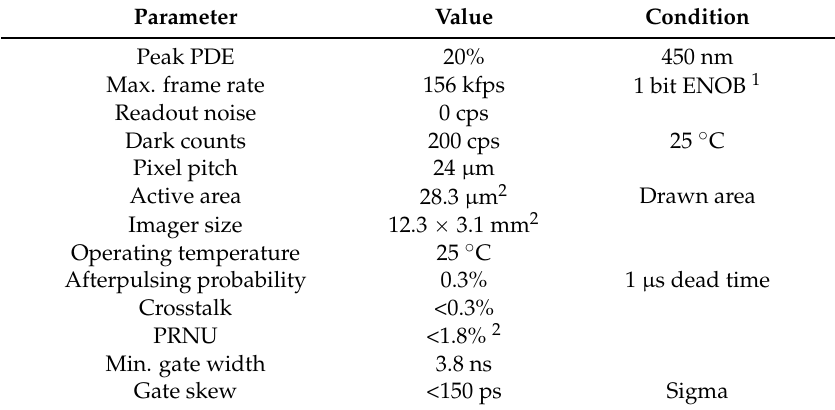
Table 1. Specifications of the sensor SwissSPAD. All the values are reported at room